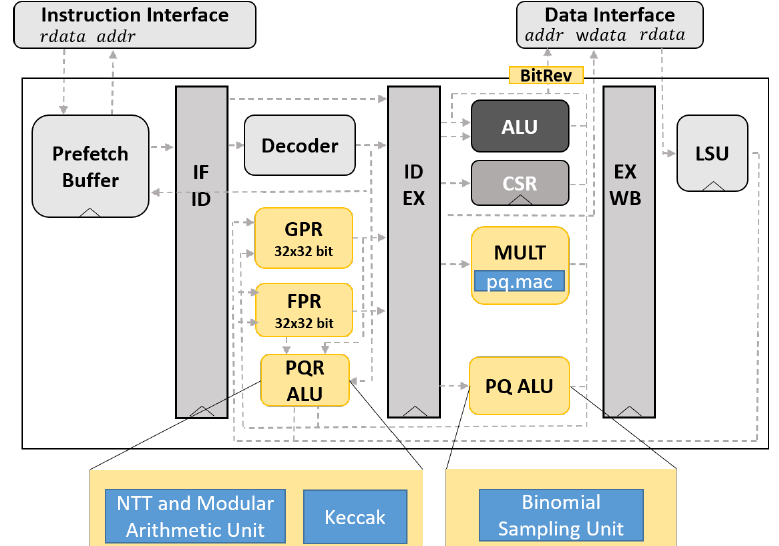
Figure 7: RISQ-V